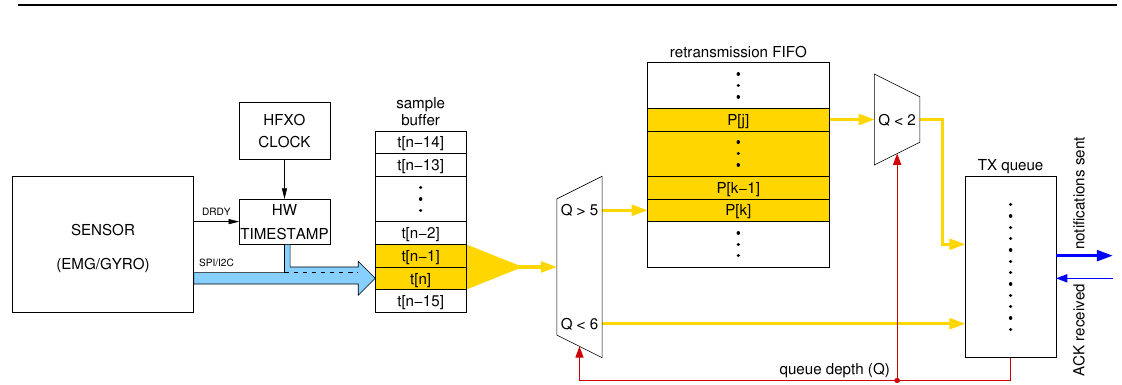
Figure 4. Illustration of the buffering strategy